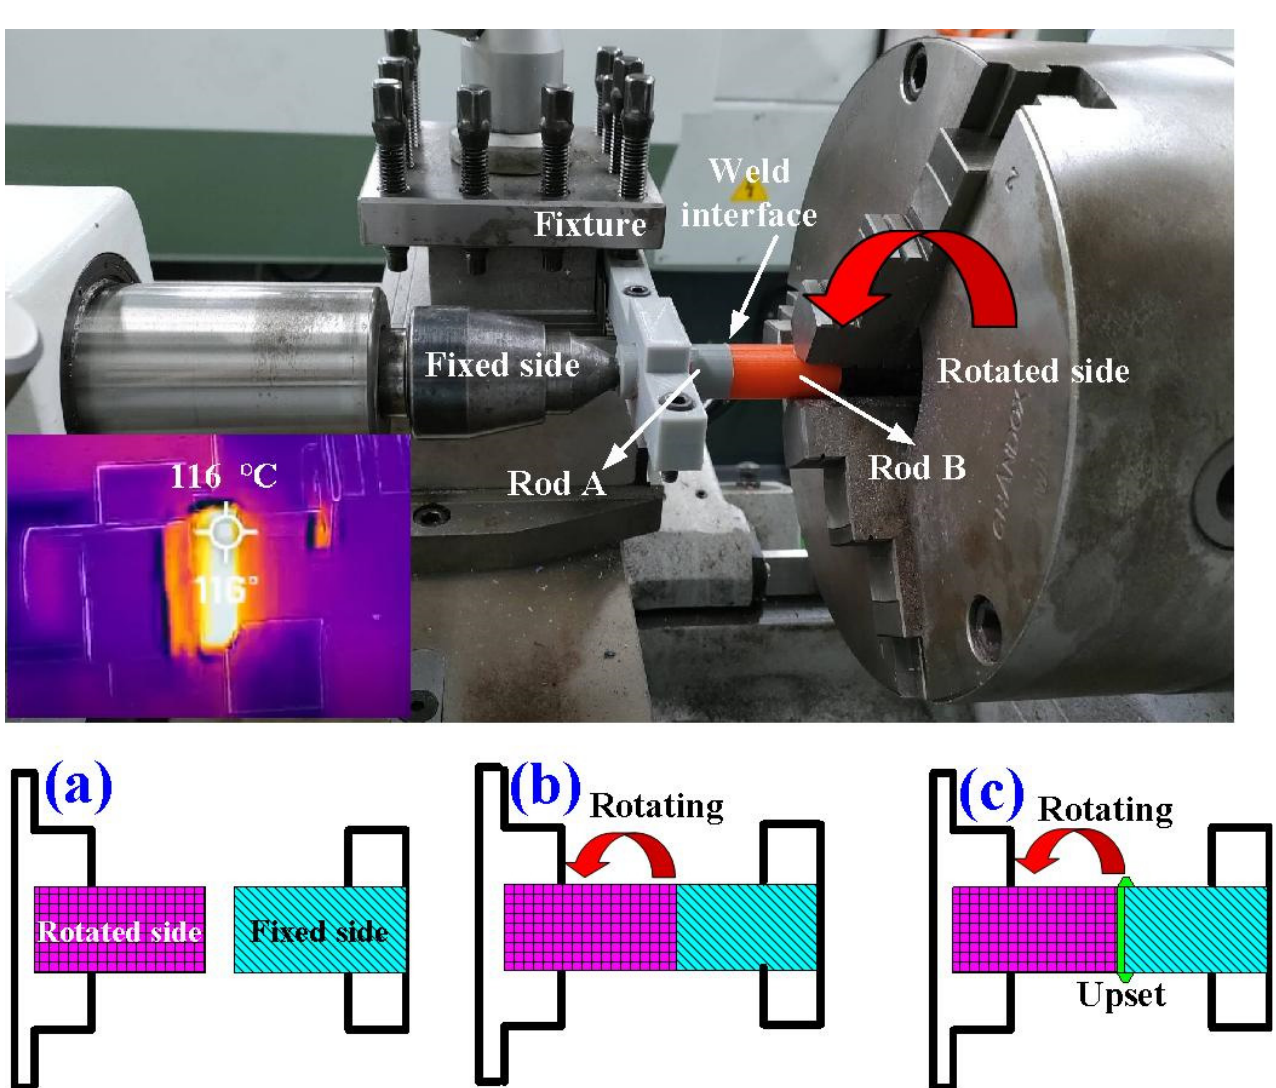
Figure 3. Situation of FW and schematic illustration of FRW process. ( a ) Installing two welding specimens in the conventional turning machine, ( b ) rotating one welding specimen, and ( c ) applying pressure to force FRW specimens to contact.